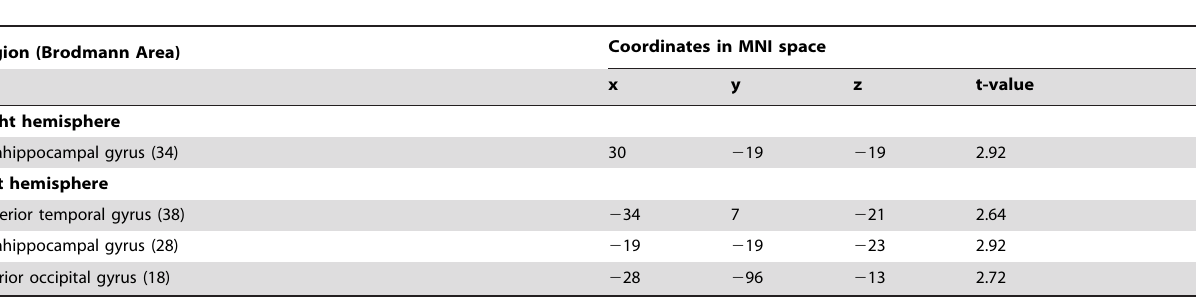
Table 5. Areas of cortical thinning in non-PNS patients compared to controls.